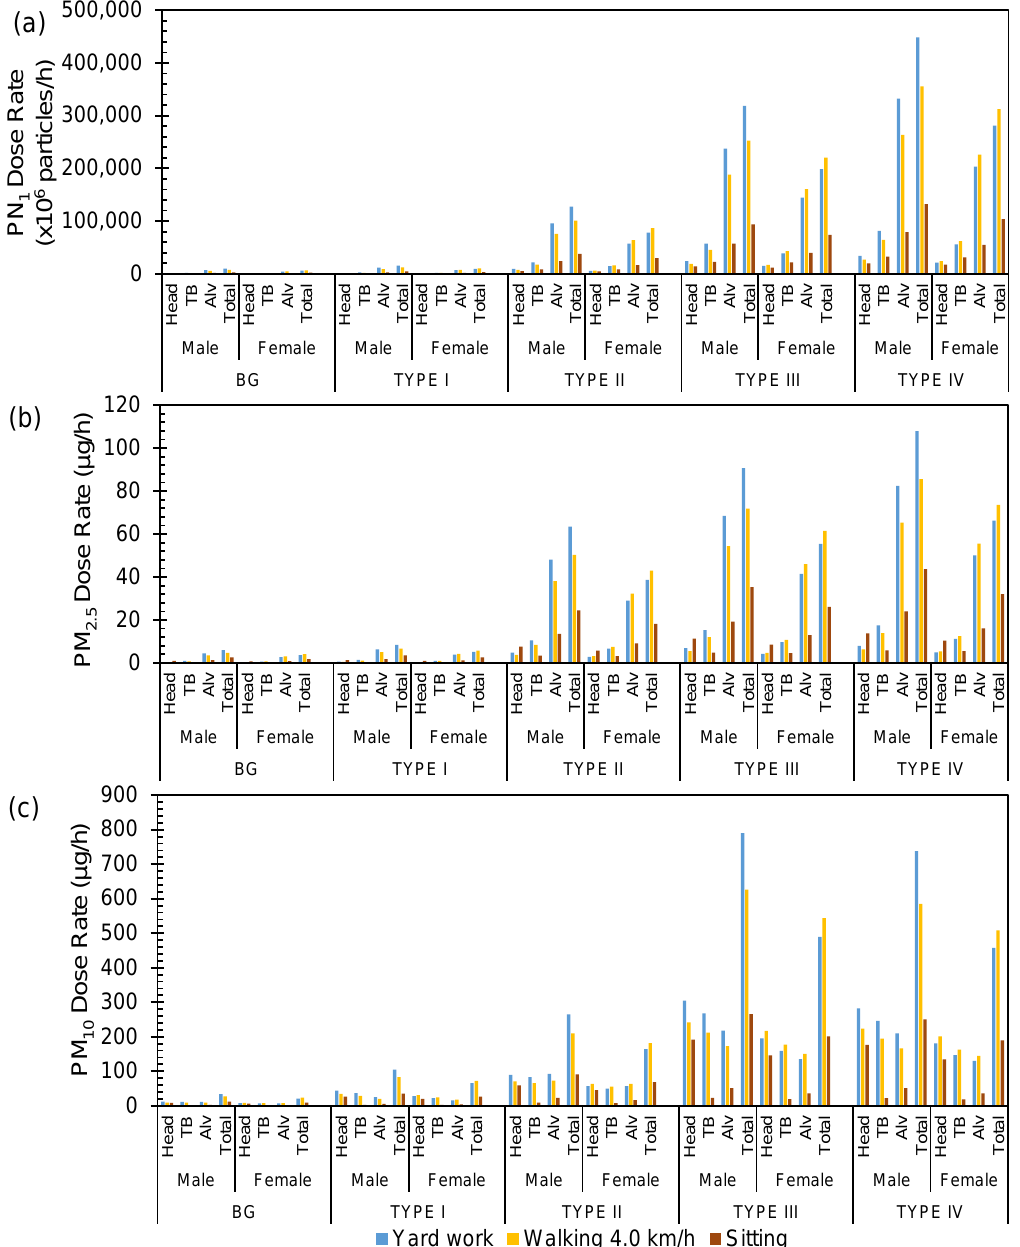
Figure 6. Regional inhaled deposited dose rates calculated for each activity type (TYPEs I, II, III, IV) and background conditions for: ( a ) sub-micron particle number concentrations (PN 1 ) and ( b , c ) particle mass concentrations (PM 2.5 and PM 10 ). The color legend is: blue—yardwork equivalent activities, yellow—walking activities, and red—sitting and resting.